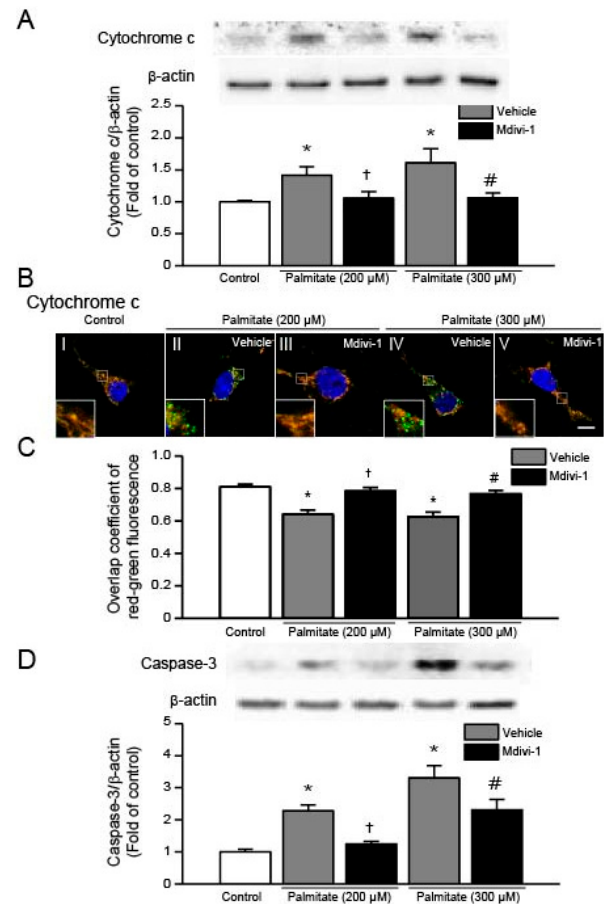
Figure 6. Effect of mdivi-1 on cytochrome c and caspase-3 levels in hippocampal NSCs exposed to palmitate insult. Cells were pretreated with DMSO vehicle or mdivi-1 (20 μ M) for 2 h and then exposed to 0.5% BSA vehicle or palmitate (200 and 300 μ M) for 24 h. Cytochrome c ( A ); and active